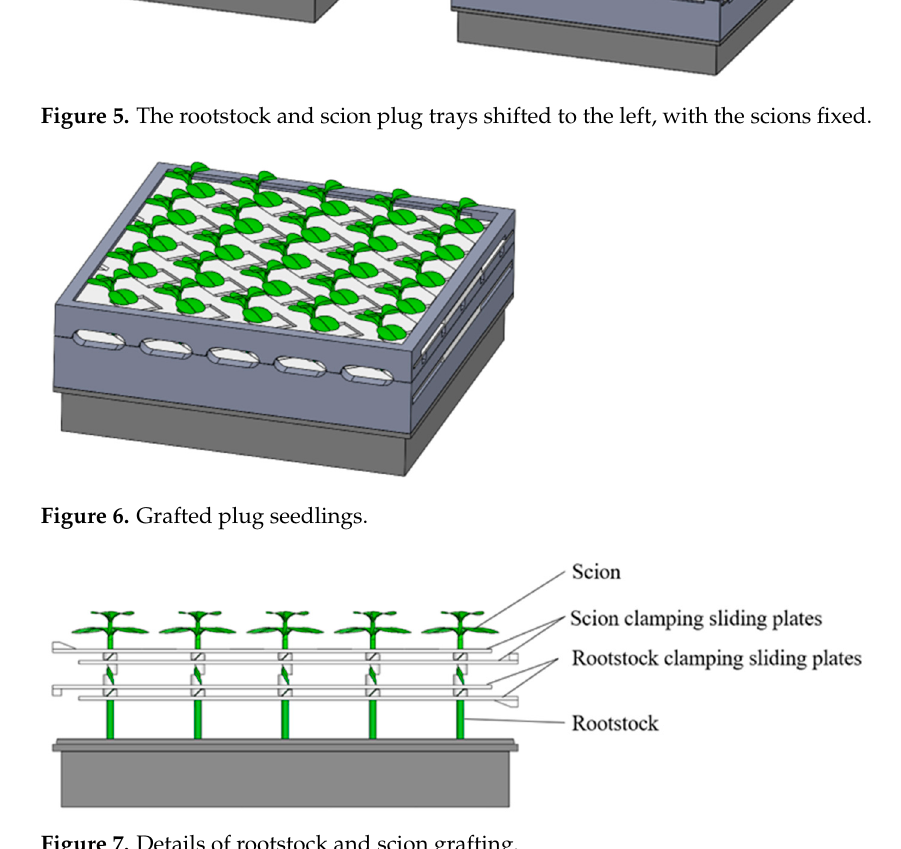
Figure 7. Details of rootstock and scion grafting.